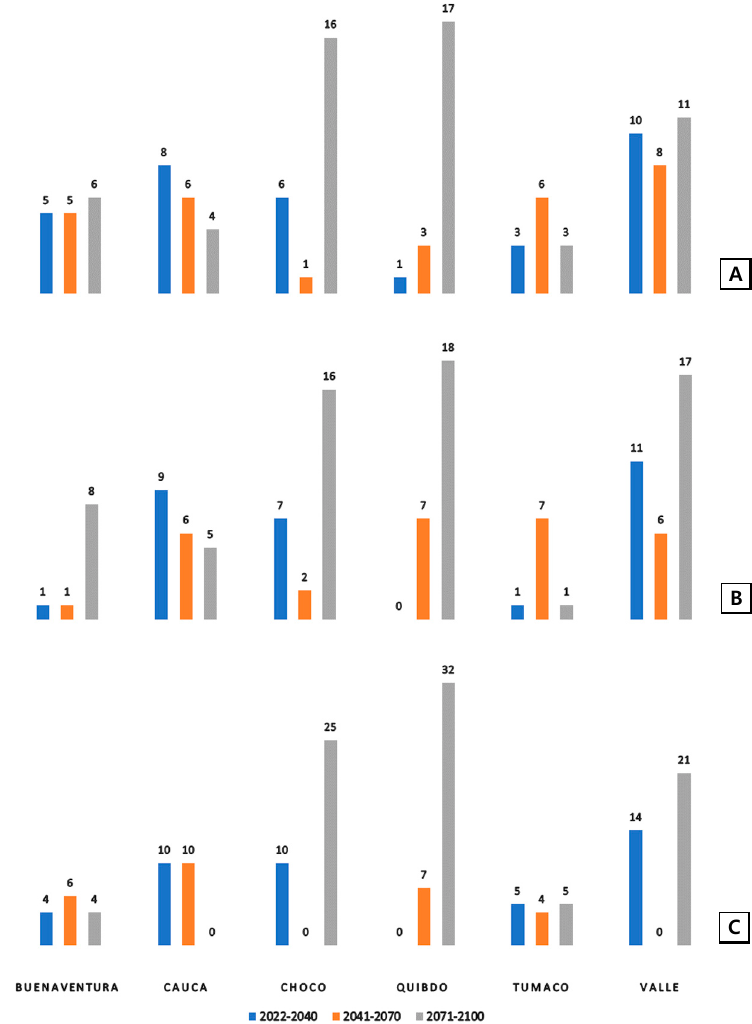
Figure 10. Number of Extremely Wet events in Colombia’s Pacific region under RCP 4.5 (2022–2100). ( A ) SPI 3; ( B ) SPI 6; and ( C ) SPI 12.